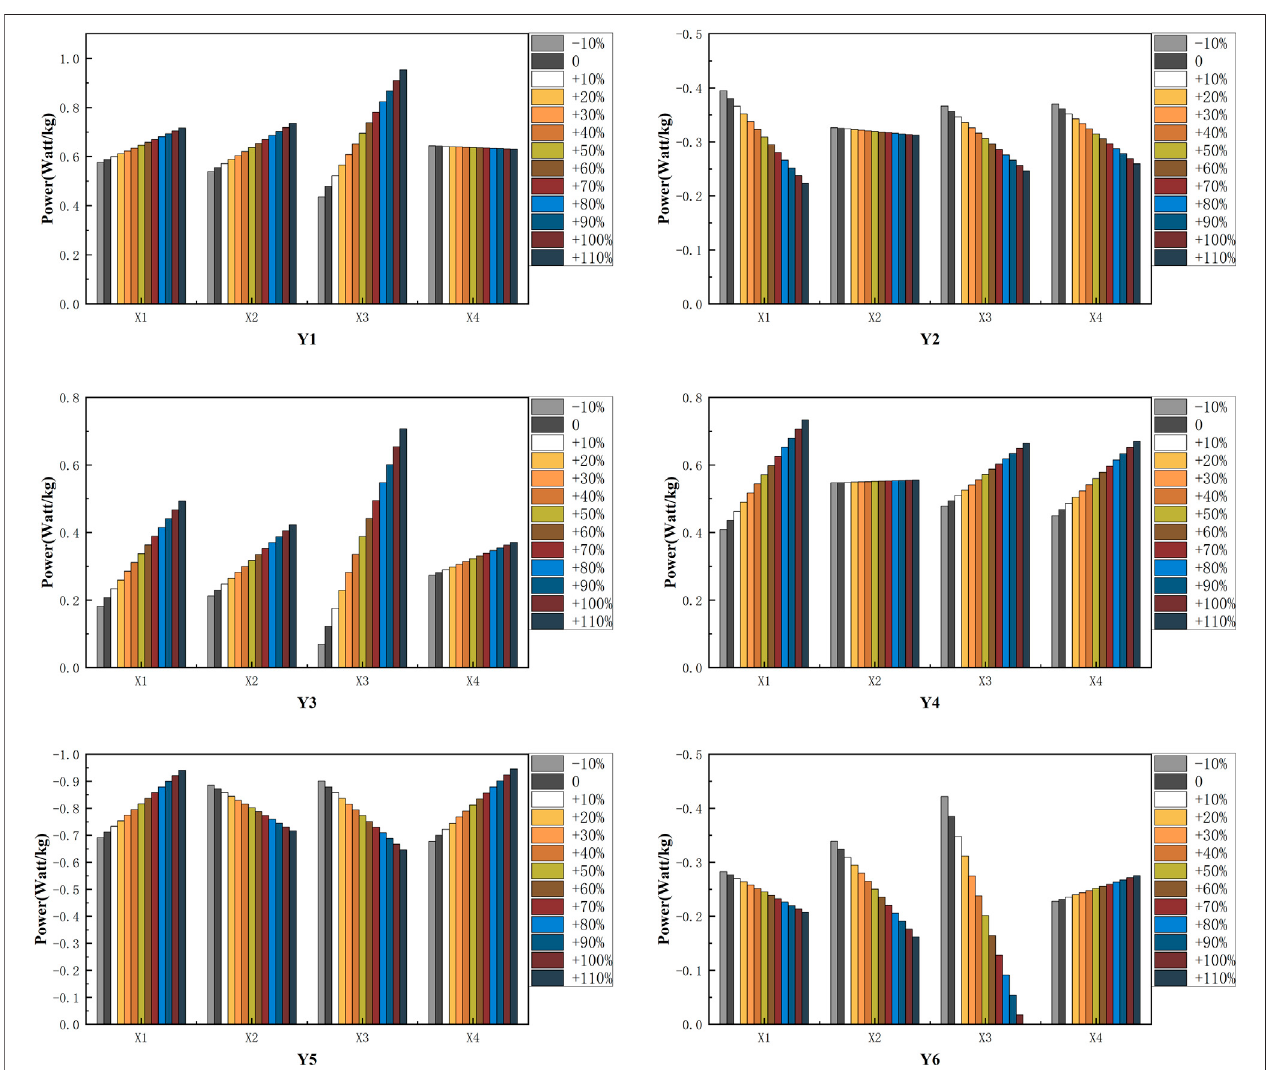
FIGURE5| ThepredictedresultsoftheresponsevariablesbaseonthePLSRmodel.Anklepositivework(Y1),anklenegativework(Y2),totalworkoftheankle(Y3), kneepositivework(Y4),kneenegativework(Y5)andtotalworkoftheknee(Y6).Initialanklejointangle(X1),initialkneejointangle(X2),rangemotionoftheankle(X3),and range motion of the knee